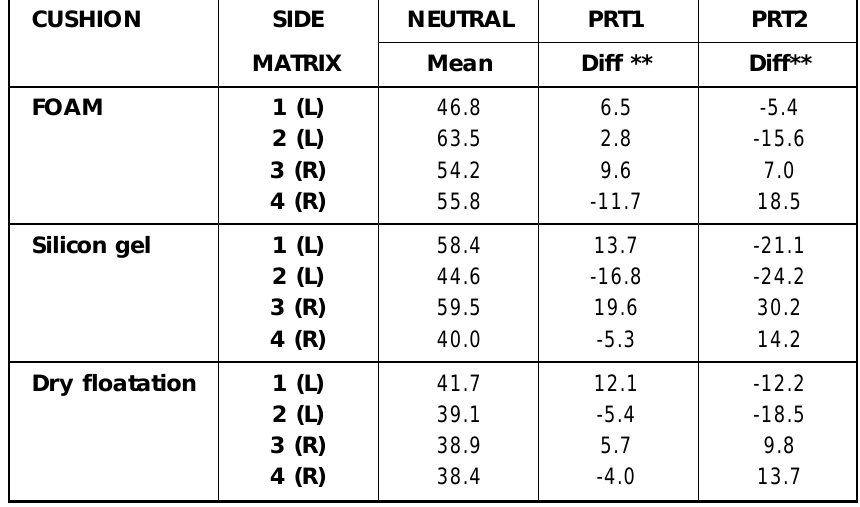
Table 3: A comparison of the mean of all twelve cells in matrices 1,2,3 and 4 (measured in mm Hg).